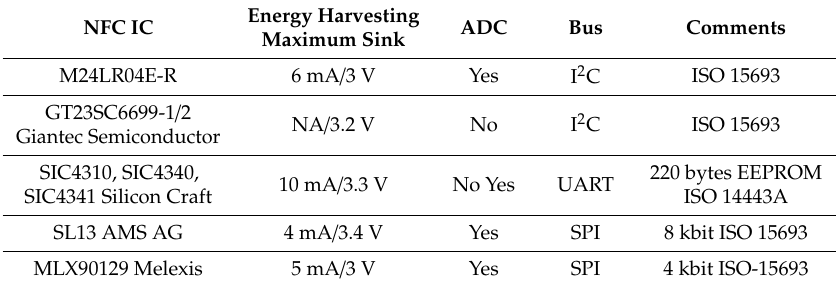
Table 2. NFC IC with the capability of energy harvesting (ADC—analog-to-digital converter; SPI—serial peripheral interface; UART—universal asynchronous